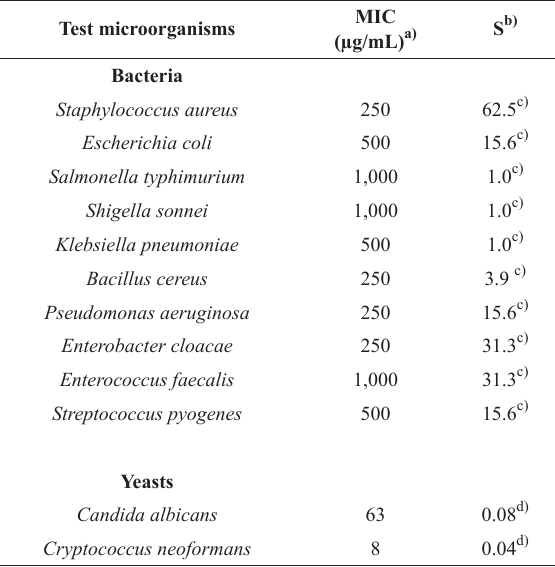
Antimicrobial activity of Mitracarpus frigidus essential